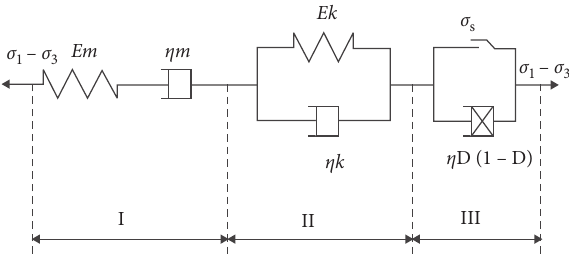
Figure 14: Constitutive model of nonlinear creep. Table 4: Parameters determined by fitting analysis based on creep tests of the gritstone rock.